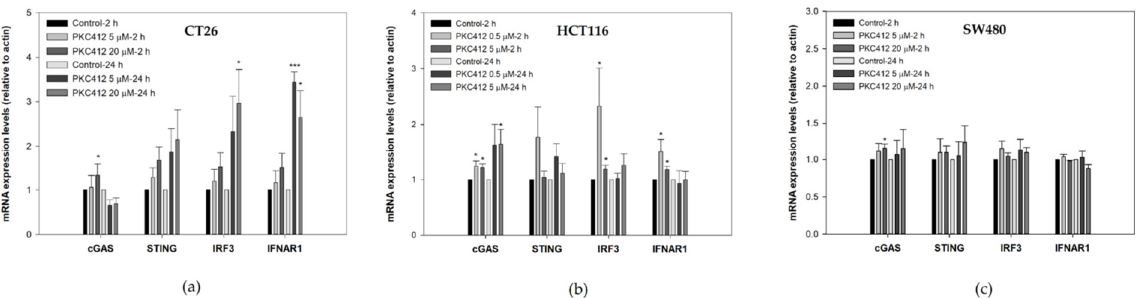
Figure 5. mRNA expression levels in CT26 ( a ), HCT116 ( b ), and SW480 ( c ) cells after treatment with midostaurin (PKC412). After treatment, RNA samples were isolated, followed by reverse transcription of RNA using primers of DNA-sensing specific genes. Data from four independent experiments were expressed as mean ± SEM. Significant differences between control cells and cells treated with PKC412 are indicated by * p < 0.05 and *** p < 0.001.